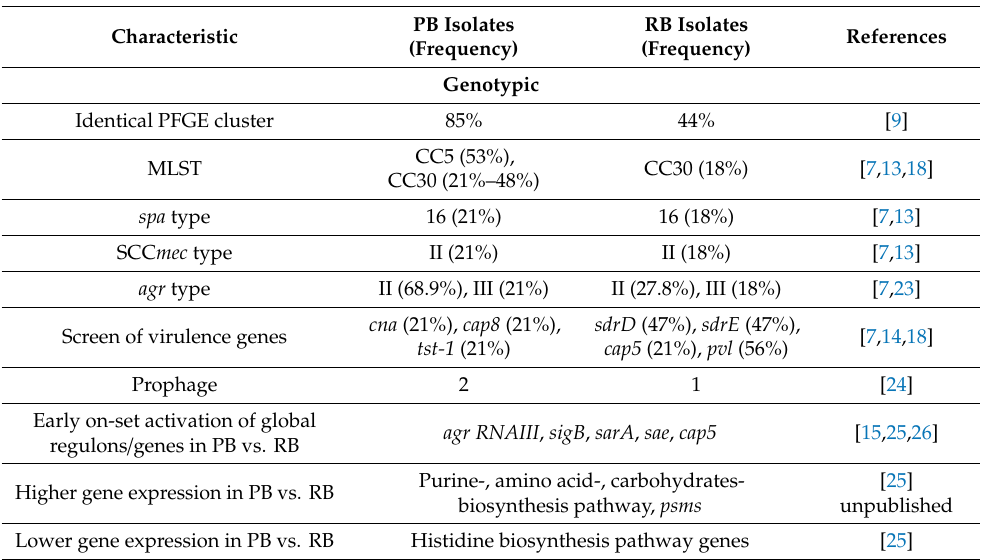
Table 1. Genotypic and phenotypic comparison of methicillin-resistant Staphylococcus aureus (MRSA) isolates from persistent bacteremia (PB) and resolving bacteremia